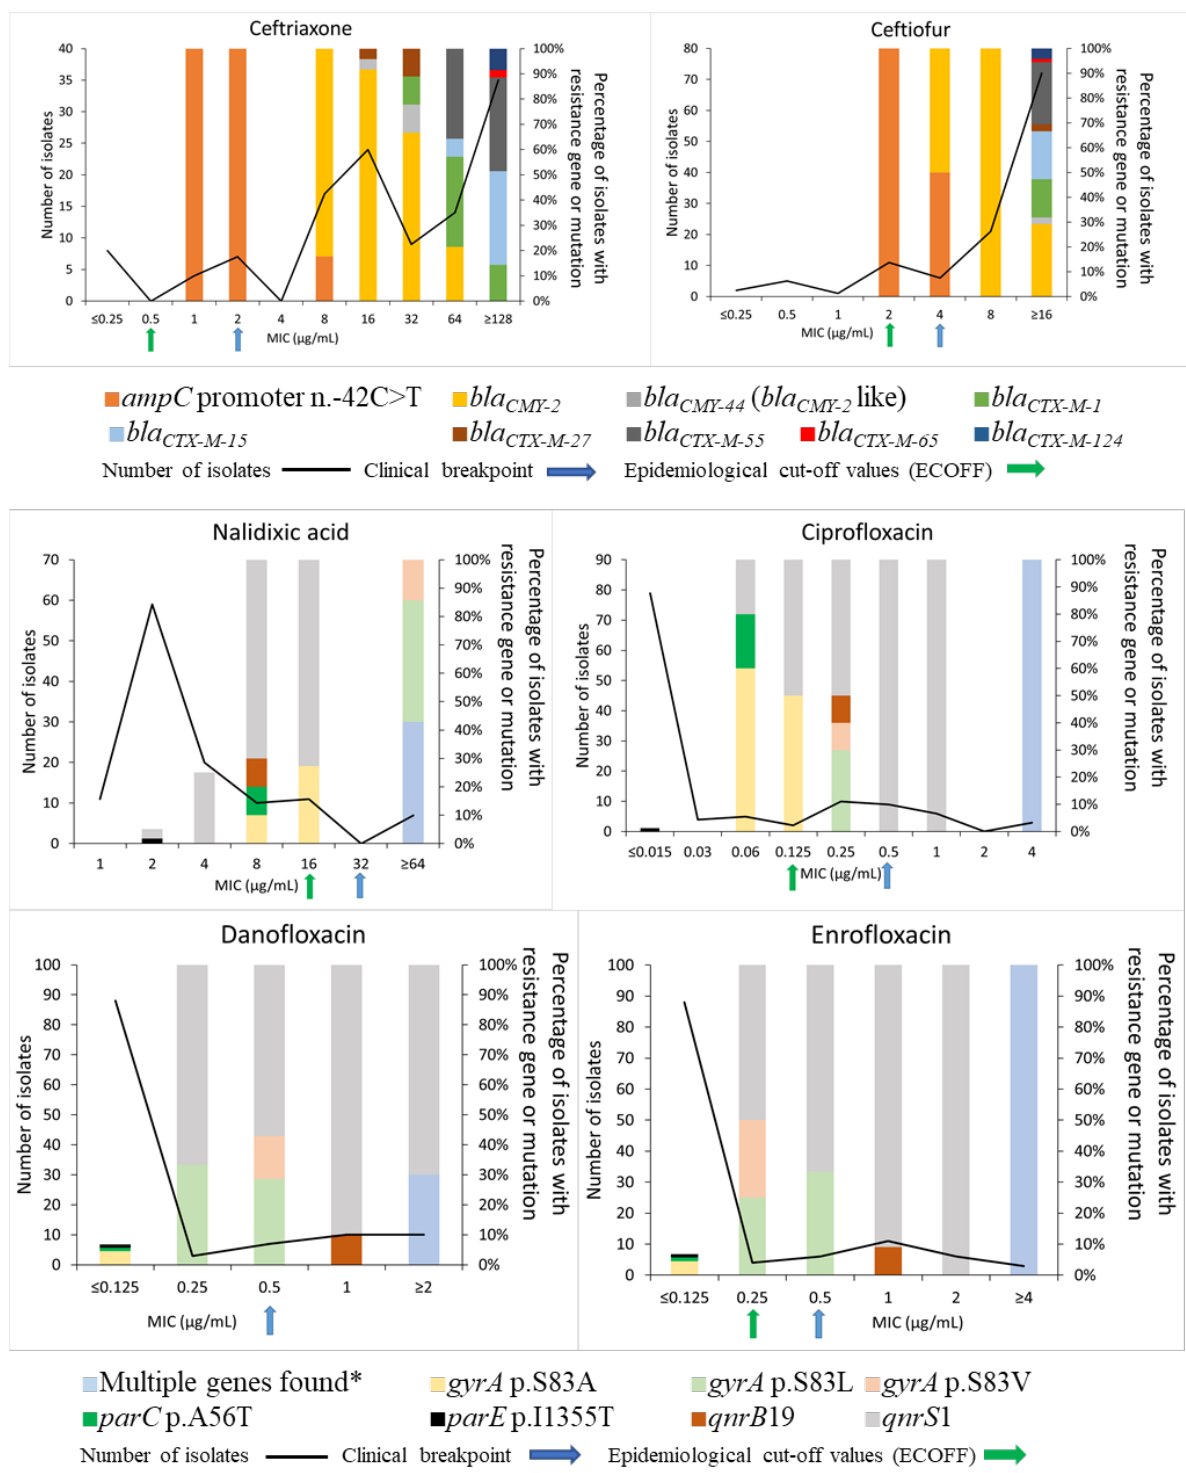
Figure 1. Correlation between an increase in the minimum inhibition concentration (MIC) and the presence of an antimicrobial resistance gene or resistance-associated mutation for third-generation cephalosporins and (fluoro)quinolones for a selection of the most resistant Escherichia coli ( n = 118) isolated from manure at 101 dairy farms in Québec, Canada. * Three isolates harboured multiple mutation points with or without an antimicrobial resistance gene: isolate 10090027-CTX ( gyrA p.D87N, gyrA p.S83L, parC p.S80I, and parC p.A56T), isolate 10640027-CTX ( gyrA p.D87N, gyrA p.S83L, parC p.S80I, and parE p.S458A), and isolate 10740013-CTX ( gyrA p.D87N, gyrA p.S83L, parC p.S80I, and qnrS 1).